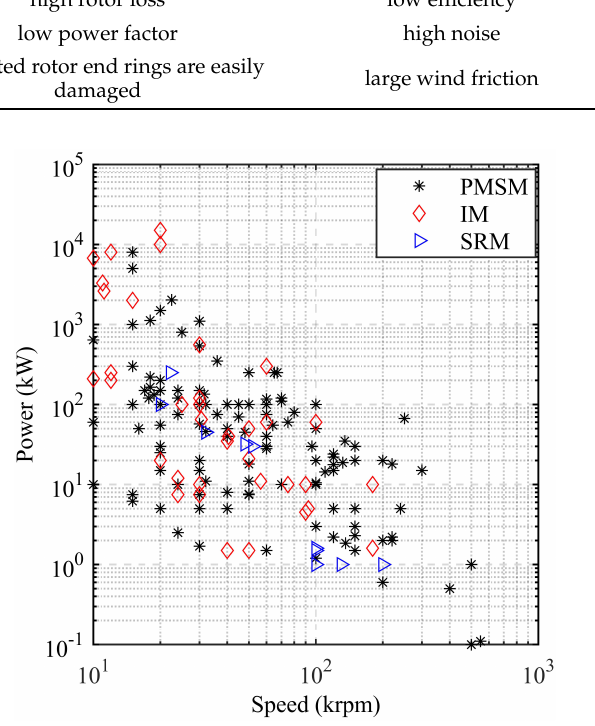
Figure 1. Speed and power distribution of high-speed motors of different structure types.